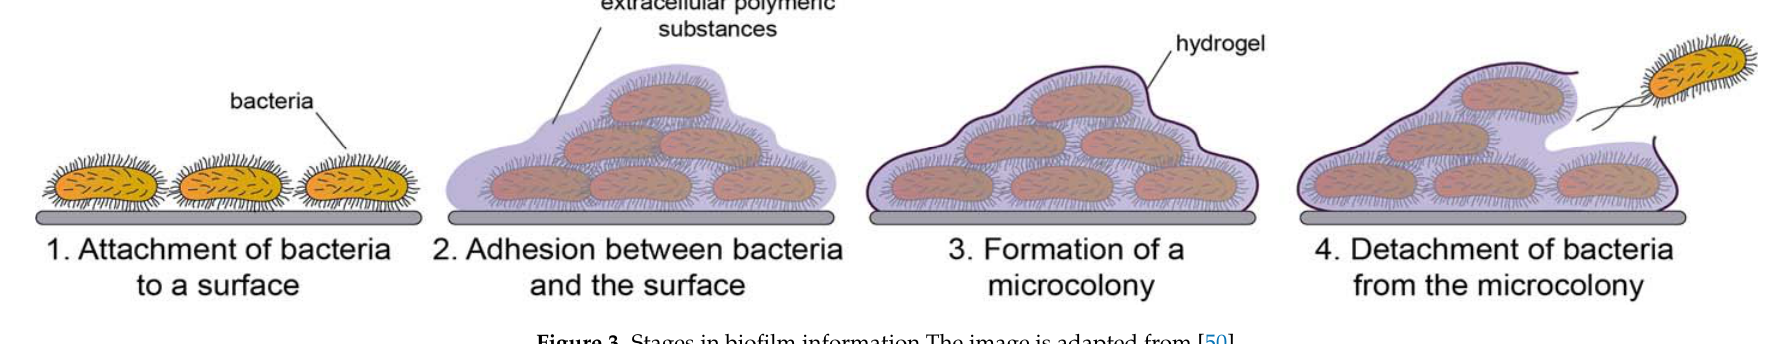
Figure 3. Stages in biofilm information The image is adapted from [50].